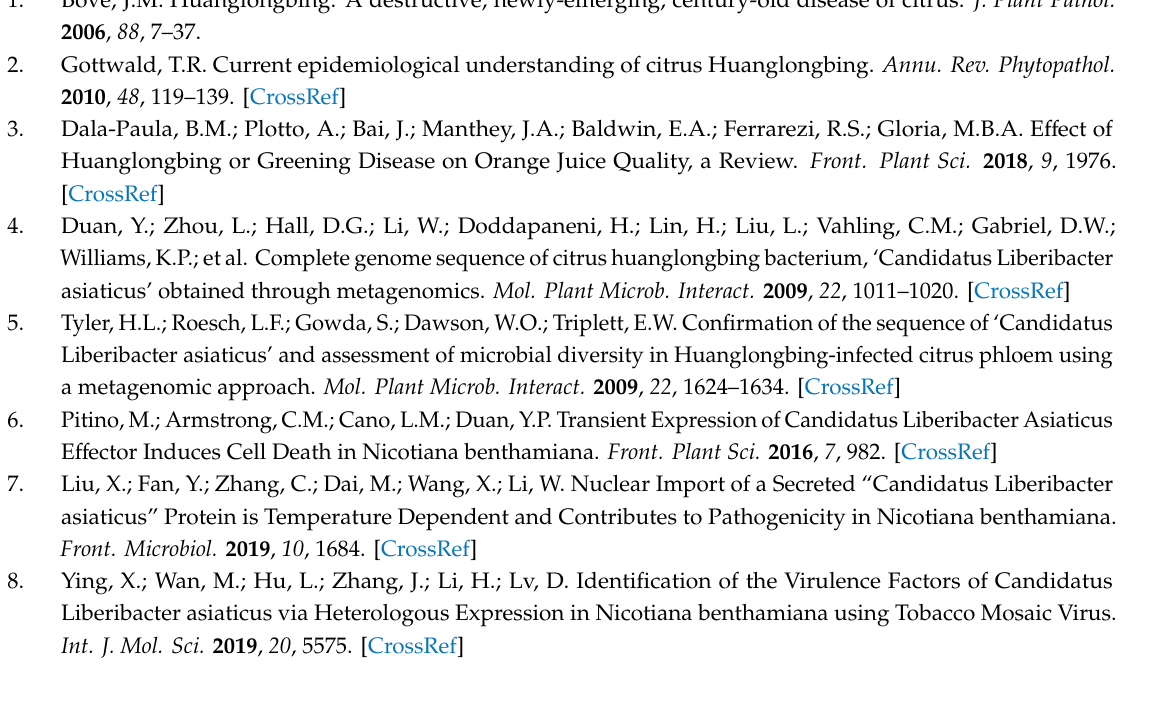
Figure S1: Distribution pattern of free GFP, m03915-GFP, and m04250-GFP in the epidermic cells of N. benthamiana ; Table S1: The primers used in this